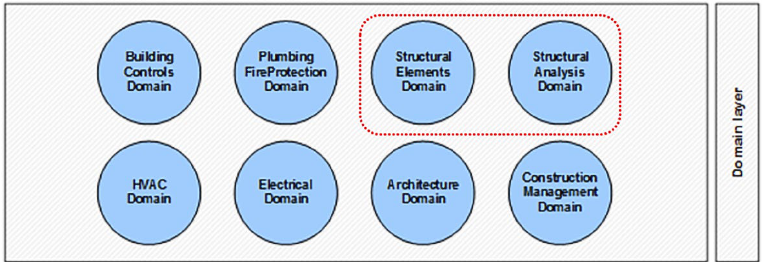
Figure 4. Domain layer of the IFC schema’s